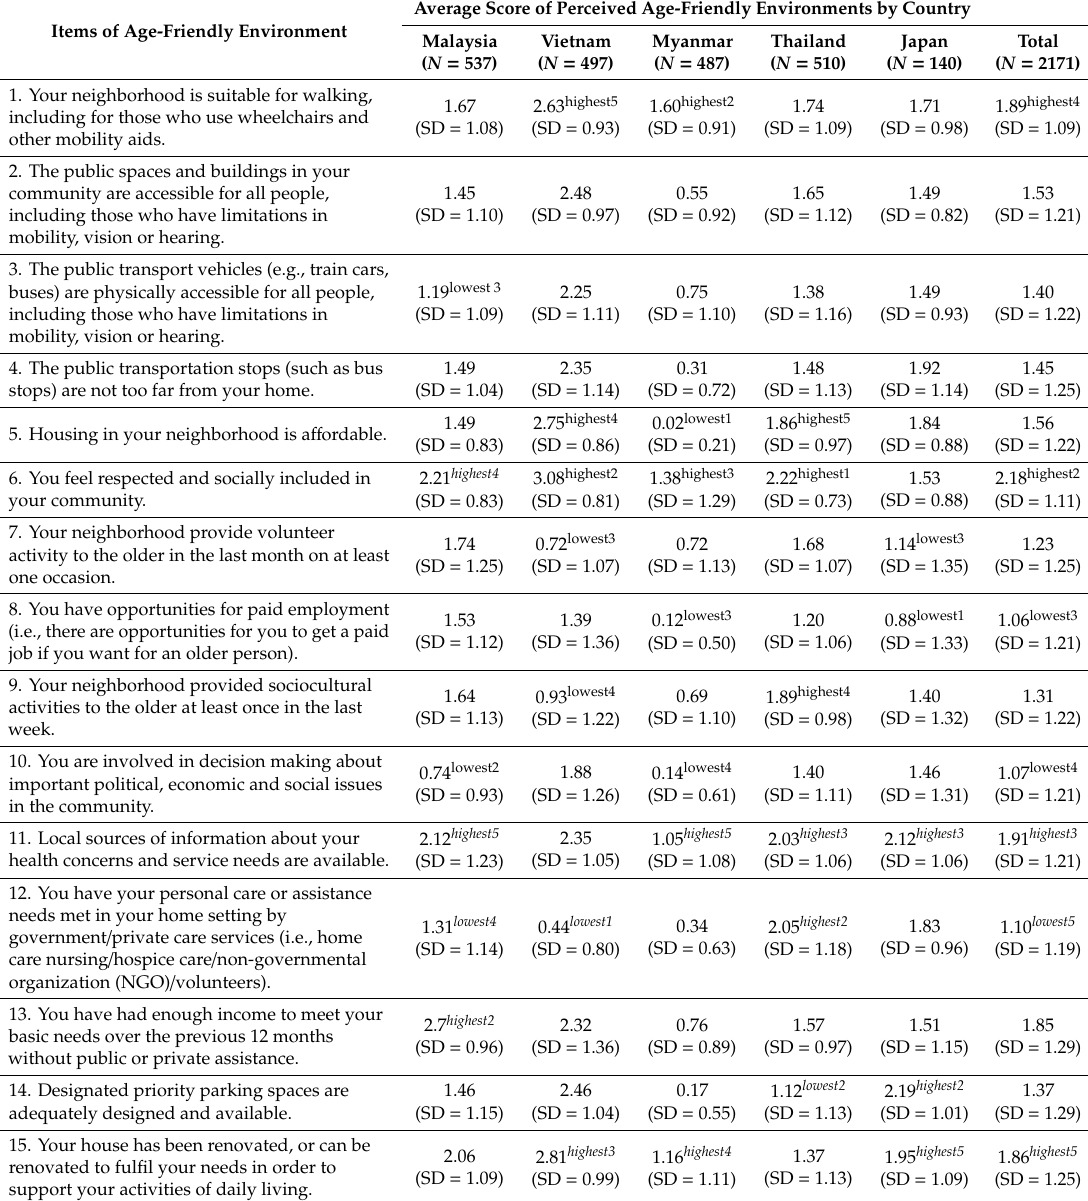
Table 2. Average score of perceived age-friendly environments calculated from the average of a